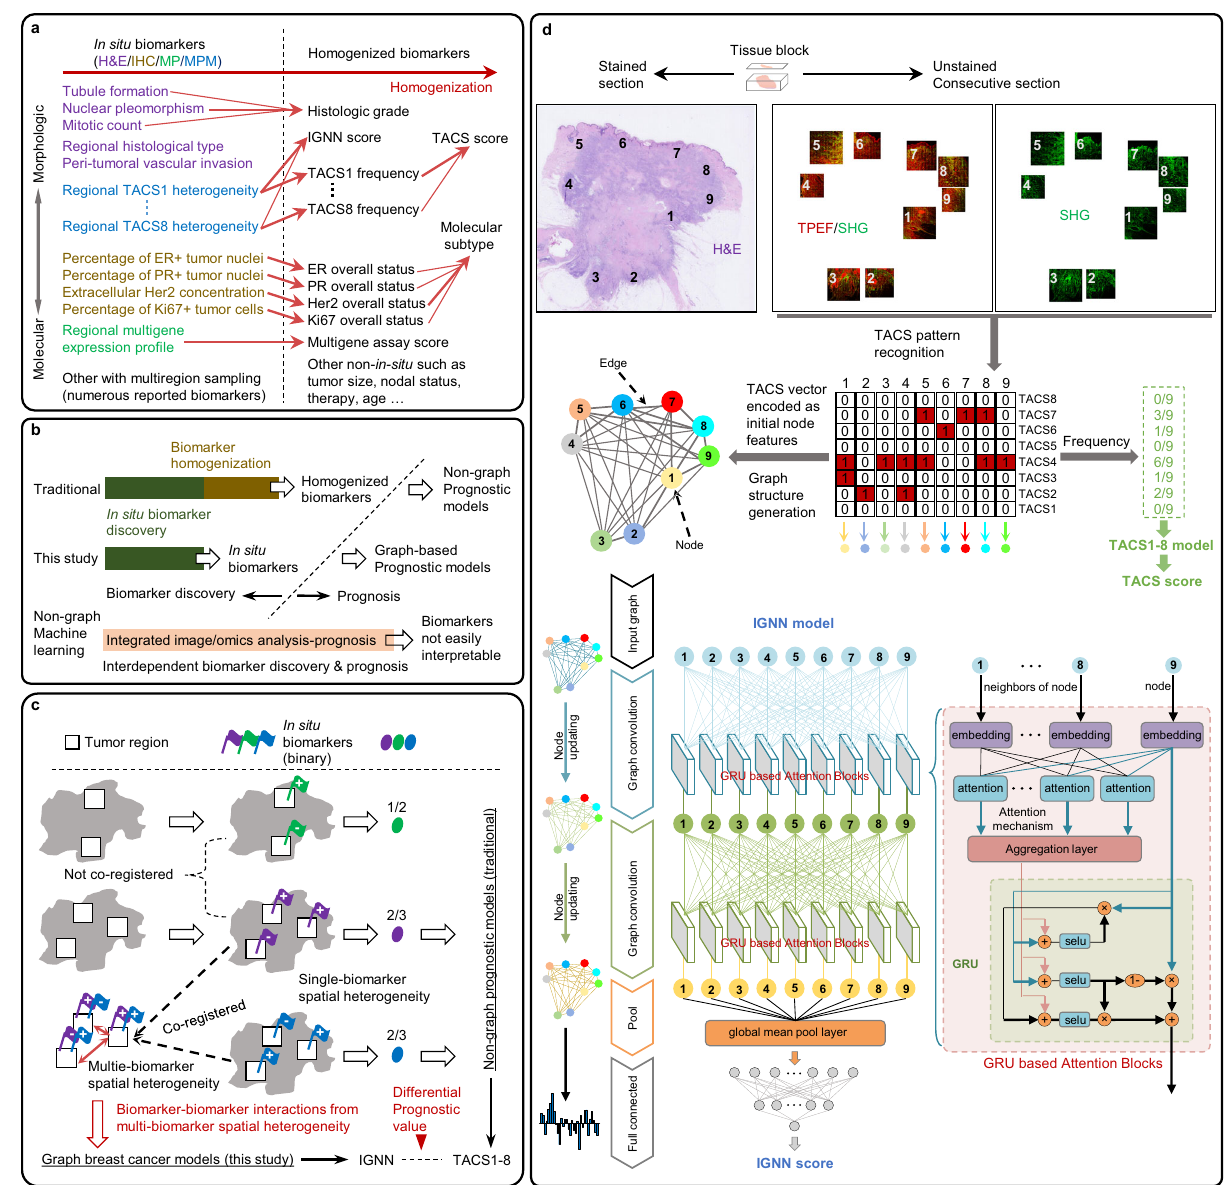
Fig. 1 GNN representation of primary breast tumor and related prognostic models. a Development of breast cancer prognostic biomarkers. b Main strategies of biomarker development for disease prognosis. c Co-registered multi-biomarker spatial heterogeneity (IGNN) in primary breast tumor with biomarker-biomarker interactions unavailable from corresponding single-marker heterogeneity (TACS1-8). d Personalized TACS1-8 reginal distributions in co-registered images (H&E, MPM of second harmonic generation SHG, and MPM of two-photon excited fl uorescence TPEF) from one exemplary patient (9 regions/nodes, each of which encoded with an 8-bit vector) that result in one graph structure input for IGNN model and another non-graph input for TACS1-8 model. In the IGNN model that ends with an IGNN score, GRU based attention blocks execute node information propagation and aggregation along the graph structure and keep or remove node information related to prognostic prediction, whereas graph convolution and full connection extract prognostic graph representation and high-dimensional features sequentially. H&E hematoxylin and eosin, IHC immunohistochemistry, MP molecular pro fi ling, ER estrogen receptor, PR progesterone receptor, HER2 human epidermal growth factor receptor 2, Ki67 speci fi c nonhistone nuclear protein, MPM multiphoton microscopy, TPEF two-photon excited (intrinsic) fl uorescence, SHG second harmonic generation, TACS (TACS1-8) tumor-associated collagen signatures, IGNN intratumor graph neural network, GRU gated recurrent units, SELU scaled exponential linear